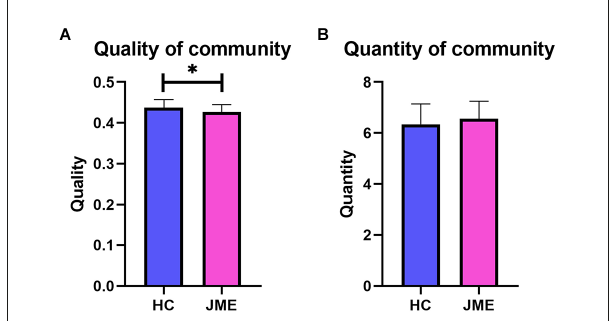
FIGURE2 Differences between the healthy controls group and the JME patients group in quality and quantity of community. (A) Quality of community. (B) Quantity of community. Asterisks represent group differences; ∗ denotes P < 0.05, FDR-corrected.